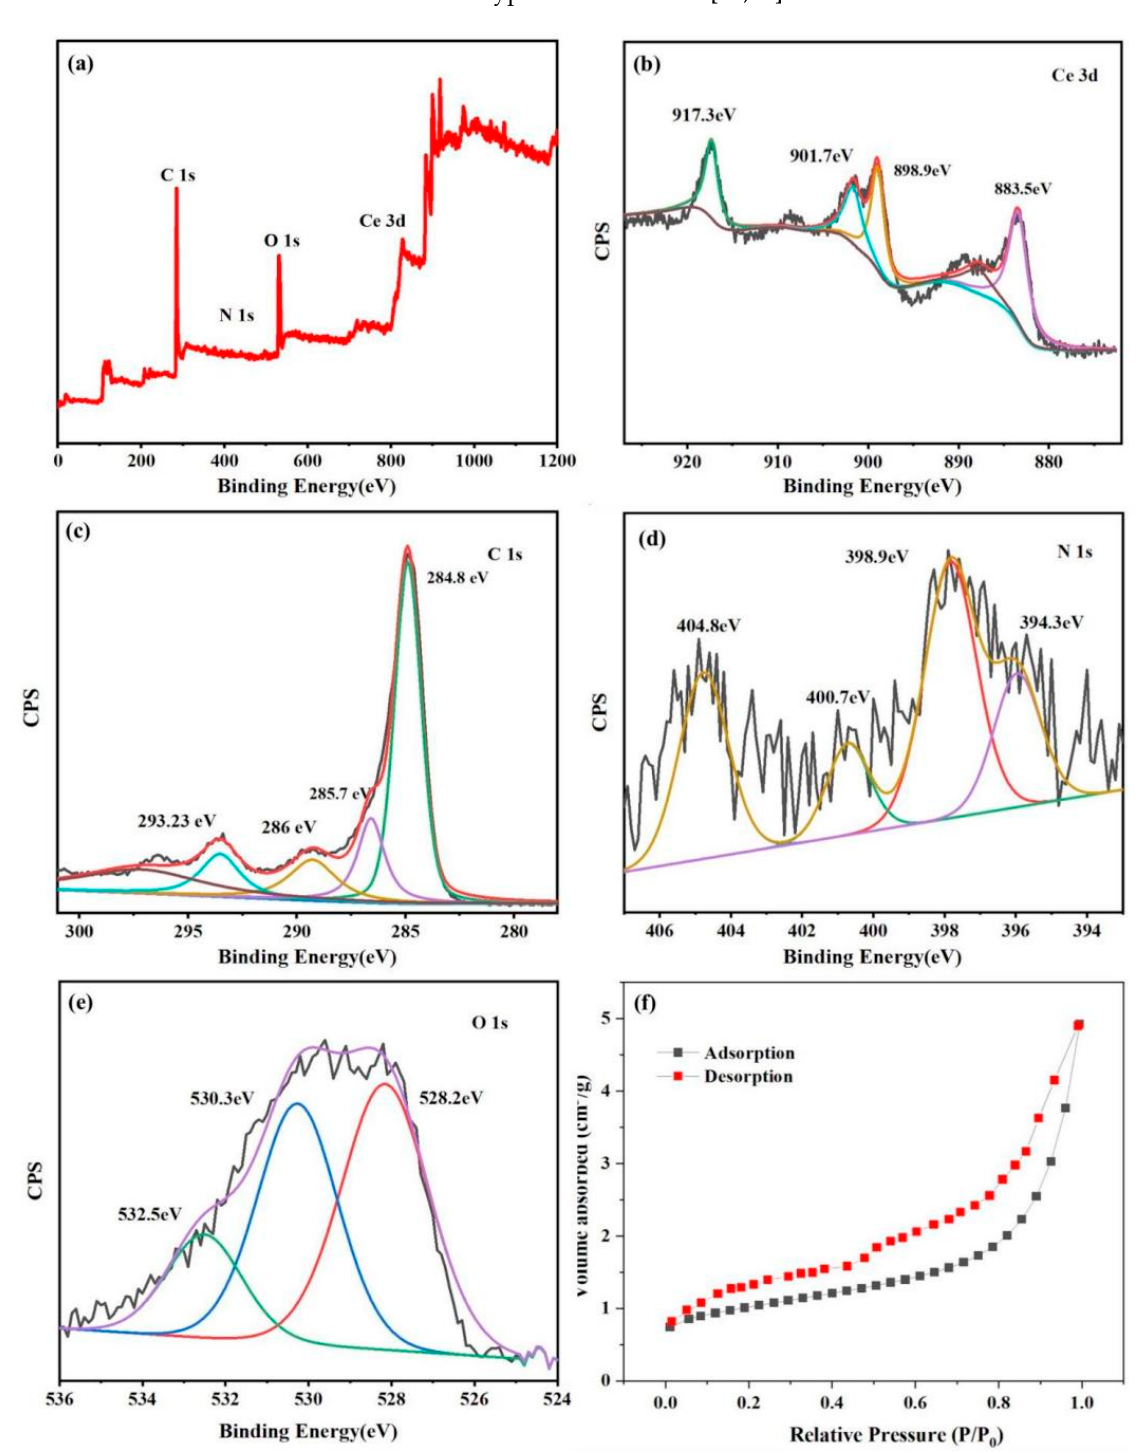
Figure 4. XPS spectra of CeSPC-600. ( a ) Survey spectrum; ( b ) Ce 3 d; ( c ) C 1 s; ( d ) N 1 s; ( e ) O1 s of 600 Ce-SPC; ( f ) N 2 adsorption/desorption isotherm curves for of 600 Ce-SPC.